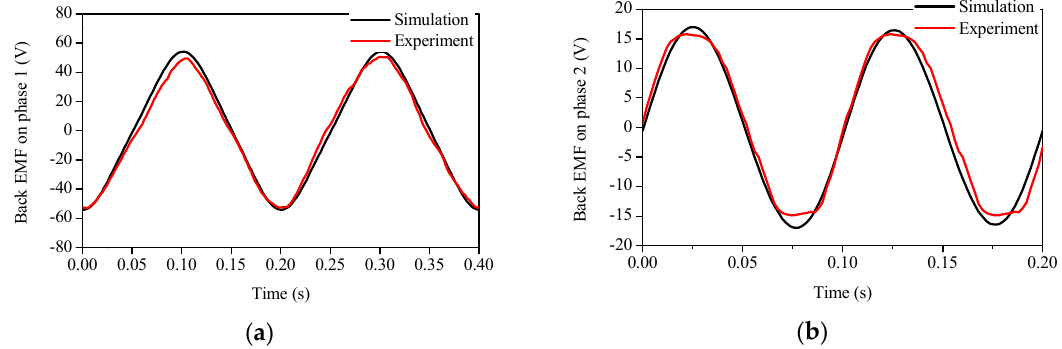
Figure 6. Comparison of the back EMF on the load resistors obtained from the FEA and experiment under a vibrating speed of 0.125 m/s: ( a ) Phase 1; ( b ) Phase 2.